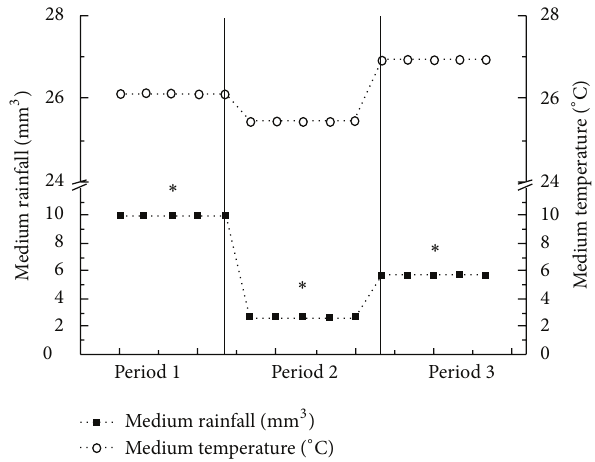
Figure 1: Medium rainfall and medium temperature for each period. Period 1 (April–July, 2010); Period 2 (August–November, 2010); Period 3 (December 2010 to March 2011). Data were obtained from Instituto Nacional de Meteorologia (INMET, Brazil). ( ∗ ) Signif- icant difference in rainfall among the periods ( 𝑃 < 0.05